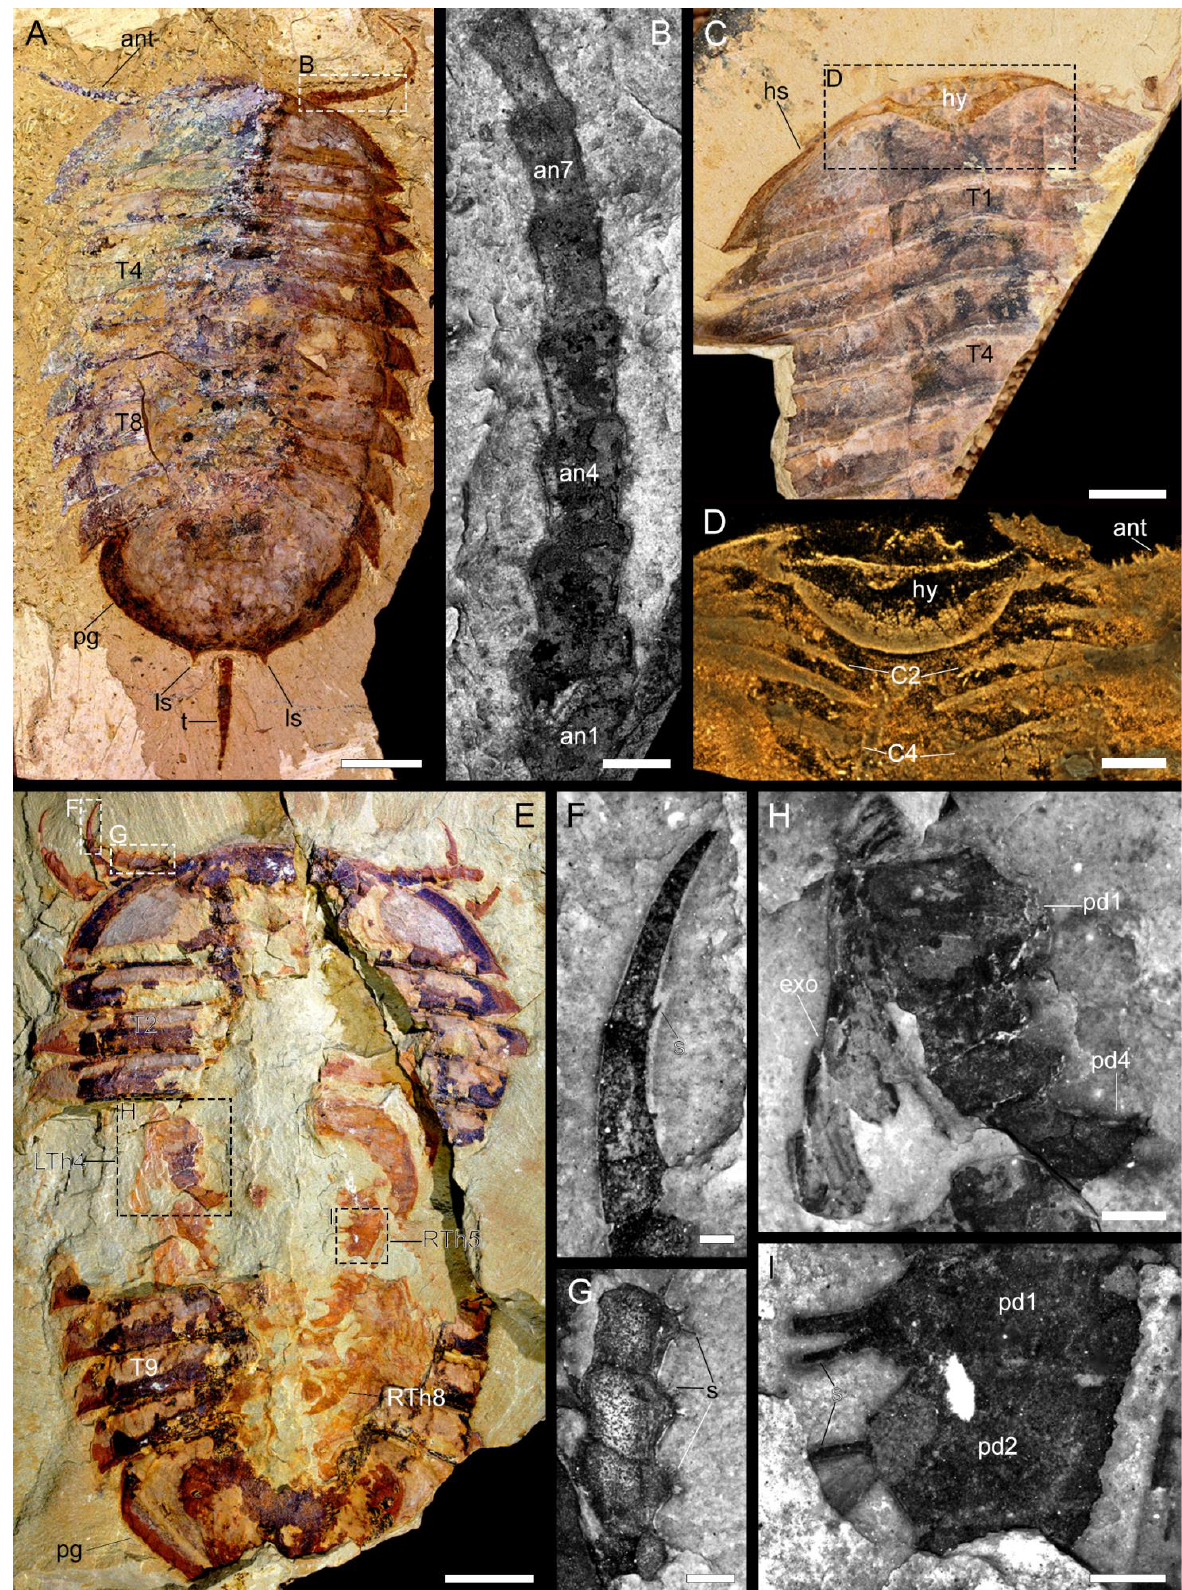
Figure 1. Macro-photographic ( A , C , E ), fluorescent ( B , F – I ), and tomographic ( D ) images of Retifacies abnormalis . ( A ) Dorsal view of YKLP 13927. ( B ) Close-up of the proximal eight annuli of right an- tenna in ( A ). ( C ) Dorsal view of YKLP 11436. ( D ) Head region shown in ( C ) demonstrates the